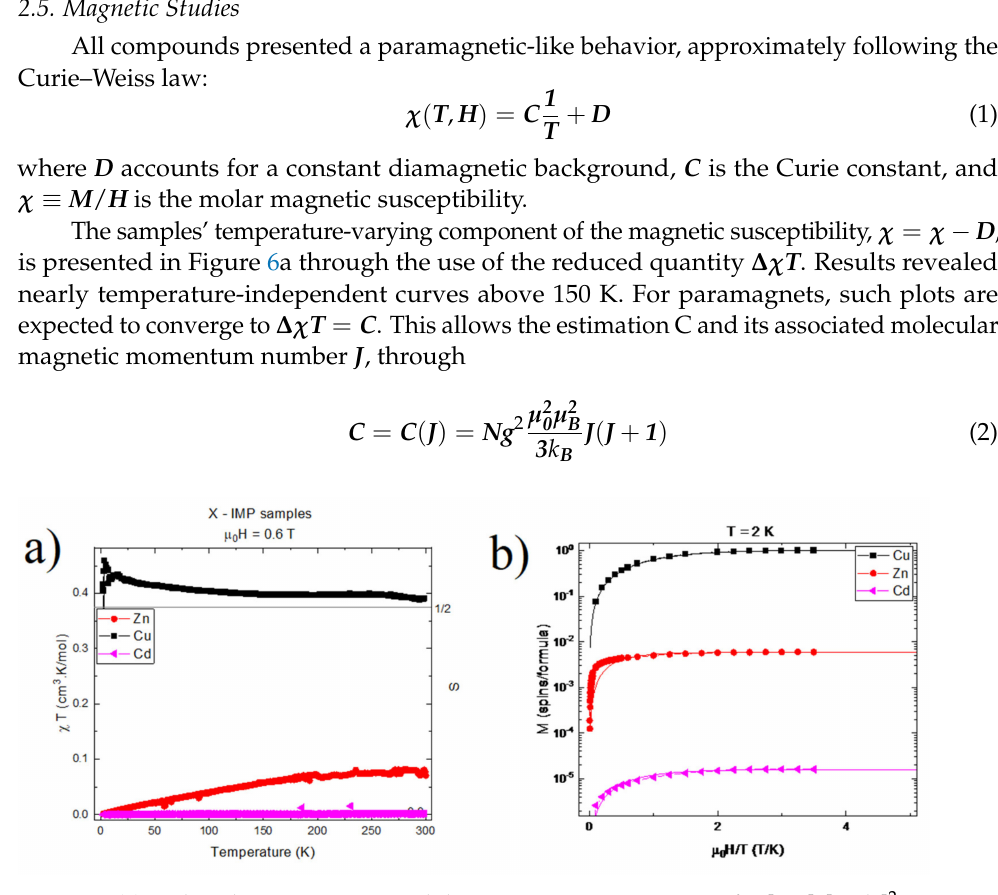
Figure 6. ( a ) Reduced magnetic susceptibility ∆ χ × T vs. temperature for [HL] 2 [XCl 4 ] 2 − , X = Zn, Cu, Cd. The subtracted diamagnetic background was D = − 1.35 × 10 − 2 cm 3 mol − 1 for X = Cu and D = − 6.5 × 10 − 4 cm 3 mol − 1 for X = Zn. No subtraction was performed for X = Cd. Measure- ments were performed under a magnetic field of µ 0 H = 0.6 T. The horizontal line corresponds to (cid:16) (cid:17) ∆ χ T = C J = 1 . ( b ) Magnetization vs. reduced magnetic field µ 0 H / T for [HL] 2 [XCl 4 ] 2 − , X = Zn, 2 Cu, Cd. Curves were obtained at T = 2 K, and had their linear diamagnetic contribution removed for clarity. The y-axis is given in units of Bohr magnetons per formula. The solid lines are function of the H / T . J = 0.59 for Cu, J = 3 for Zn, and type y ∝ B J ( x ) , B J the Brillouin function with x = gJ µ 0 µ B k − 1 B J = 1.3 for Cd. g is taken at g = 2.1 for all